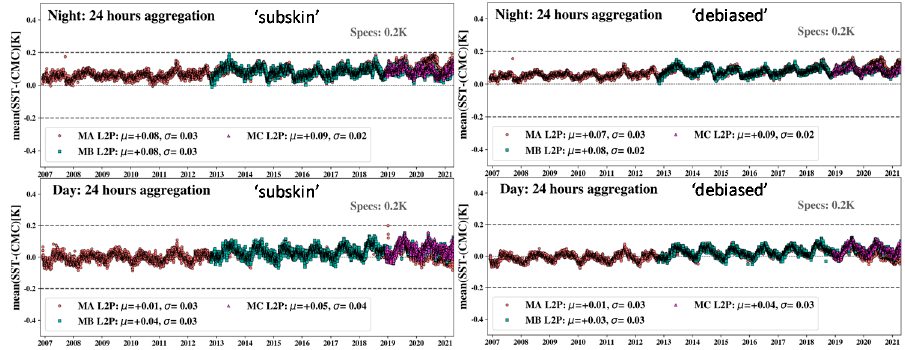
Figure 15. Time series of global ACSPO – L4 CMC SST mean biases. ( Top ) night; ( bottom ) day; ( left ) GR; ( right ) PWR.